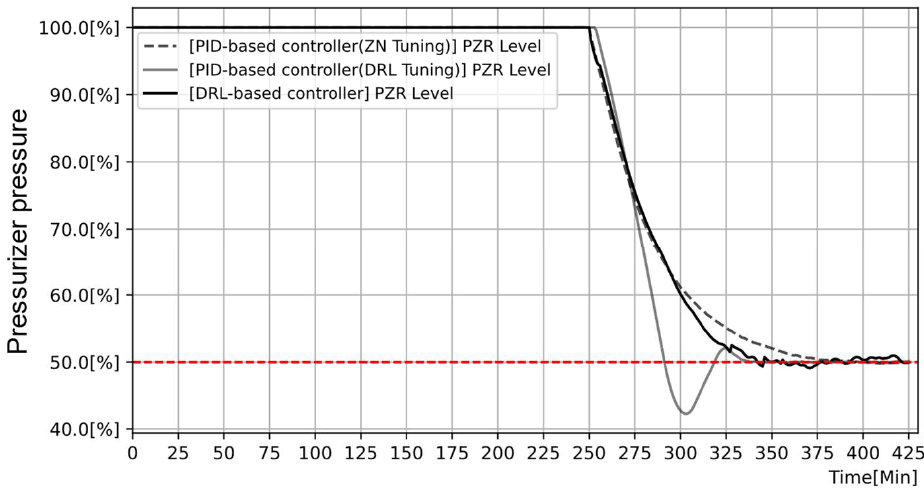
Figure 21. Accumulated error for the pressure with a reference of 27 kg/cm 2.